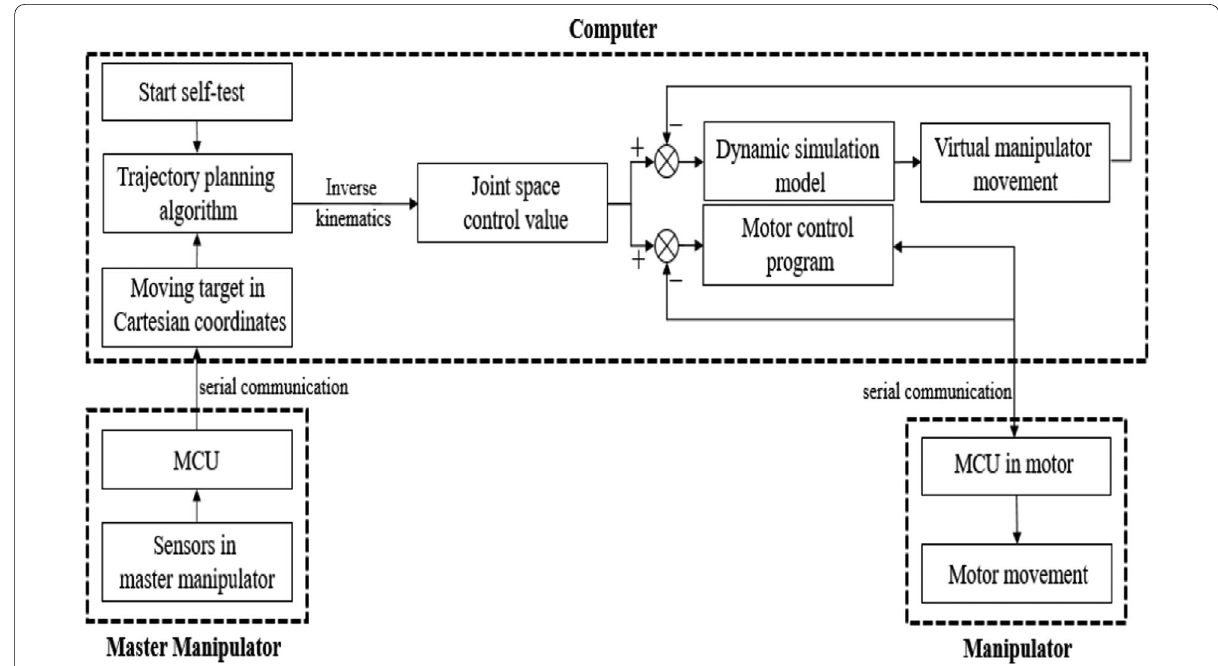
Figure 5 Block diagram of simulation control system